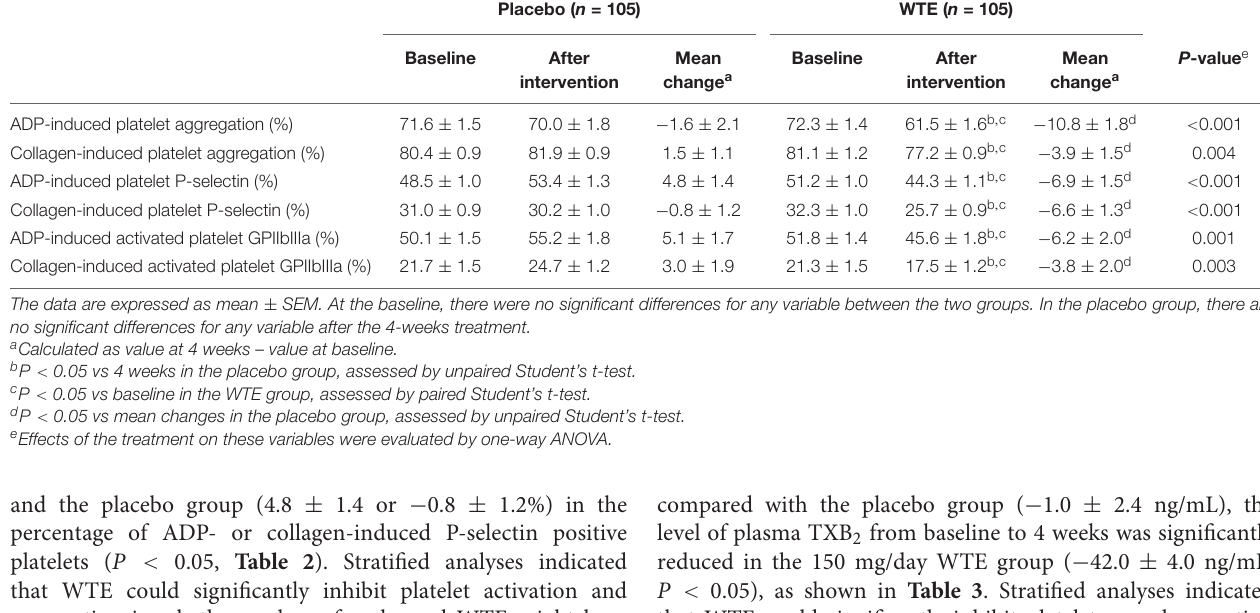
level of plasma TXB 2 from baseline to 4 weeks was